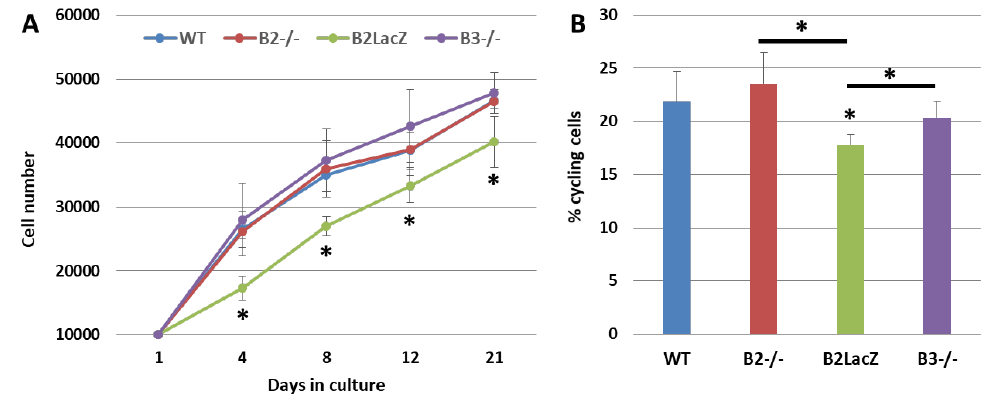
Figure 3. Growth curves and cell proliferation of both WT (wild type) and Eph-B-deficient BM-MSCs. ( A ) Cell content (×10 6 ) of WT and Eph-B-deficient MSCs at different days of culture. Note the significant reduced cellularity of Eph-B2-LacZ MSCs. ( B ) Percentage of cycling cells in the different cultures. Lower cell proportions occurred in the Eph-B2-LacZ cultures as compared to the other ones (* p value < 0.05) ( n = 5).